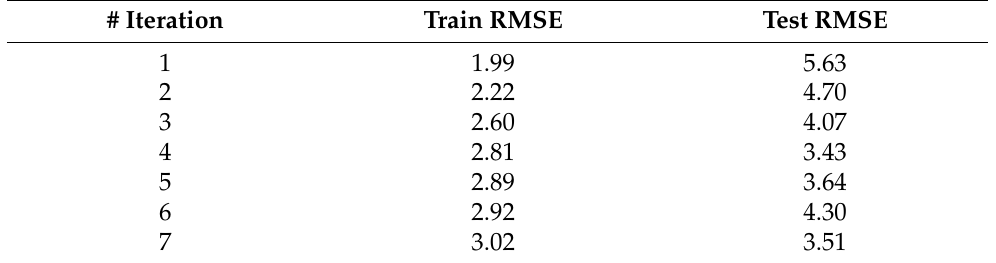
Table 6. Average RMSE for training and test sets at each iteration with time series split.